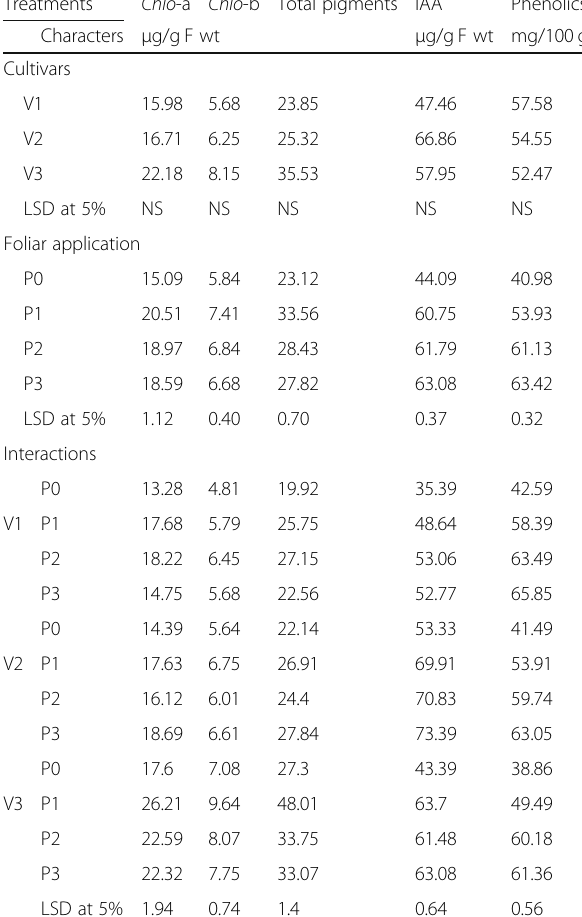
Table 4 Effect of cultivars, foliar application of garlic extract, ascorbic acid or nicotinamide and interactions on photosynthetic pigments, IAA and phenolic contents of faba bean Treatments Chlo -a Chlo -b Total pigments IAA Phenolics Characters μ g/g F wt Cultivars